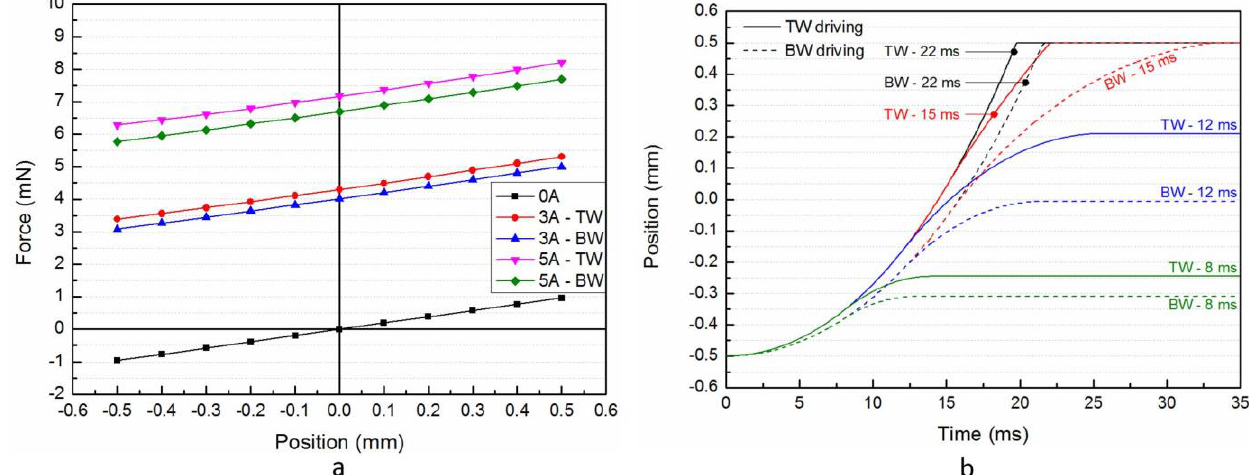
Figure 2. Simulation results: ( a ) force exerted on the MPM as function of its position and for different driving current values, and ( b) displacement curves of the MPM for different pulse